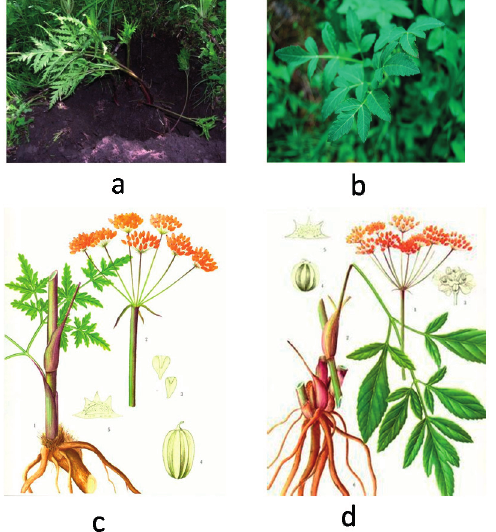
Figure 5. Pictures of NI ( a , c ) and NF ( b , d ).